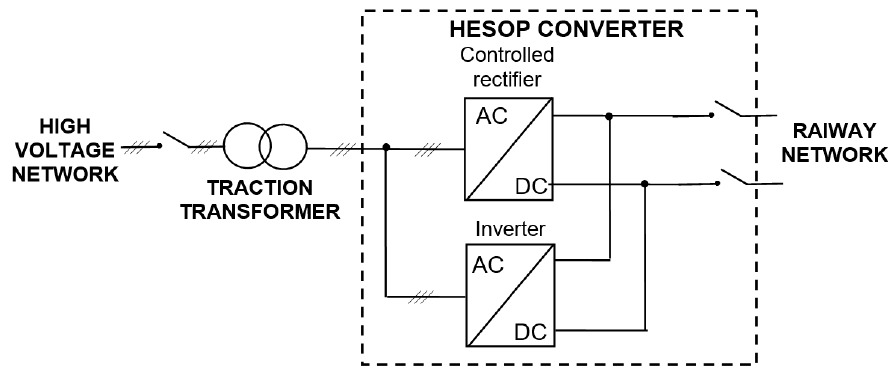
Figure 7. Structure of the prototype Harmonic and Energy Saving Optimizer (HESOP) converter [91].